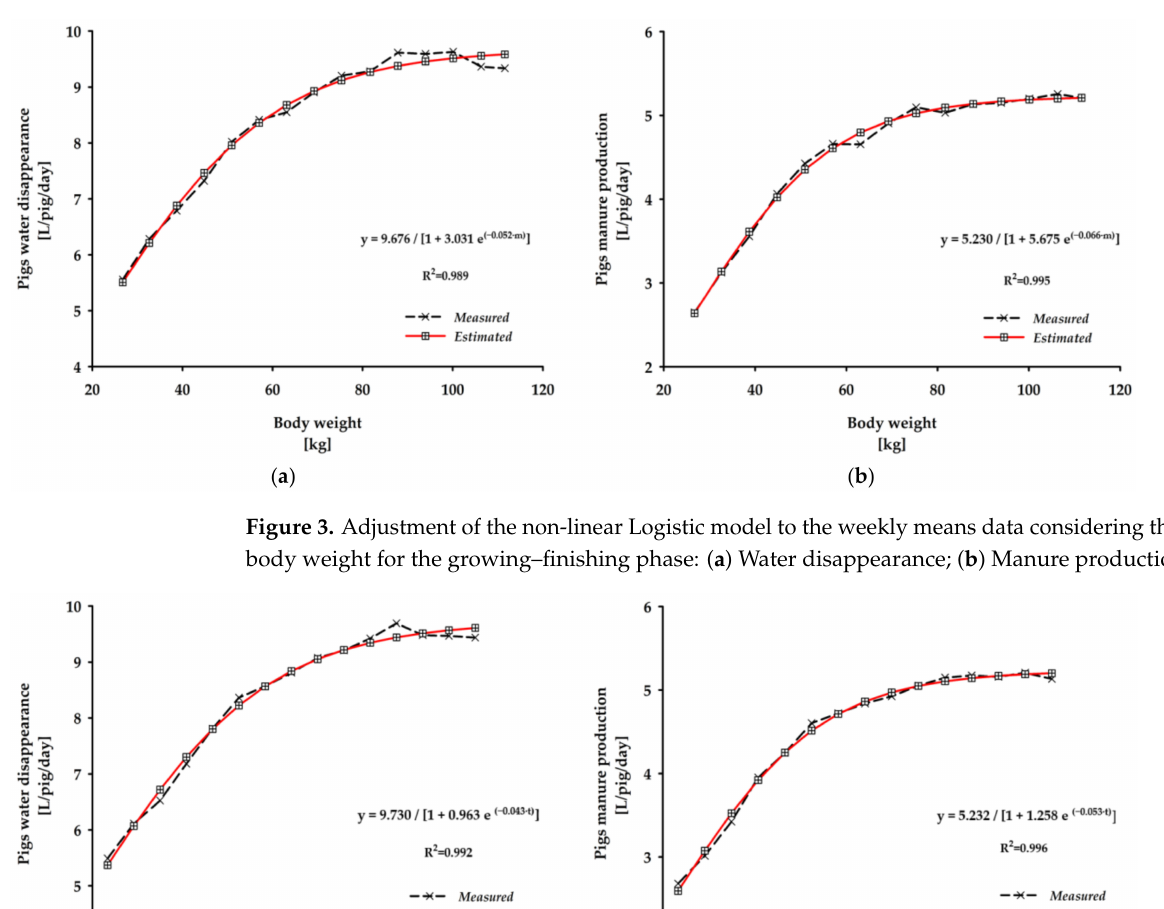
Figure 2. Adjustment of the non-linear Logistic model to the weekly means data considering the pigs’ age for the growing–finishing phase: ( a ) Water disappearance; ( b ) Manure production.